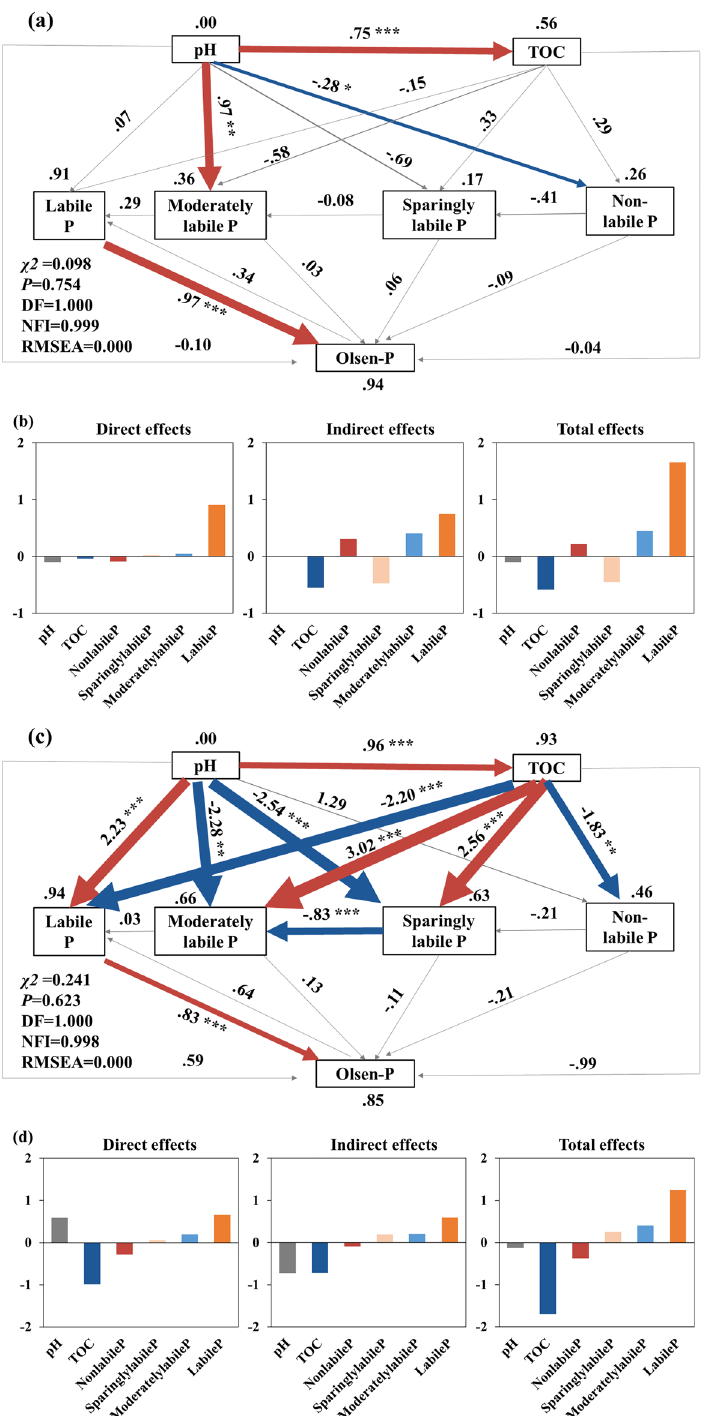
Figure 5. Structural equation model (SEM) analysis for the transformation of P fractions in response to the addition of different alternative P sources in fluvo-aquic ( a ) and red soils ( c ). Standardized direct effects, indirect effects and total effects of the factors on Olsen-P from the structural equation modeling model of fluvo-aquic ( b ) and red soils ( d ). Optimal model fitting results under the fluvo-aquic soil ( a ): χ 2 = 0.098, DF = 1, χ 2 /DF = 0.098, P = 0.754, NFI = 0.999 and RMSEA = 0.000; optimal model fitting results under the red soil ( b ): χ 2 = 0.241, DF = 1, χ 2 /DF = 0.241, P = 0.623, NFI = 0.998 and RMSEA = 0.000. The number on the arrow represents the standardized path coefficient, and the red and blue arrows represent the positive and negative effects, respectively. *, ** and *** indicate significant at P < 0.05, P < 0.01 and P < 0.001, respectively. The black number above each variable is R 2 values, which represent the explained proportion of variance for each variable. The arrow width indicates the strength of the